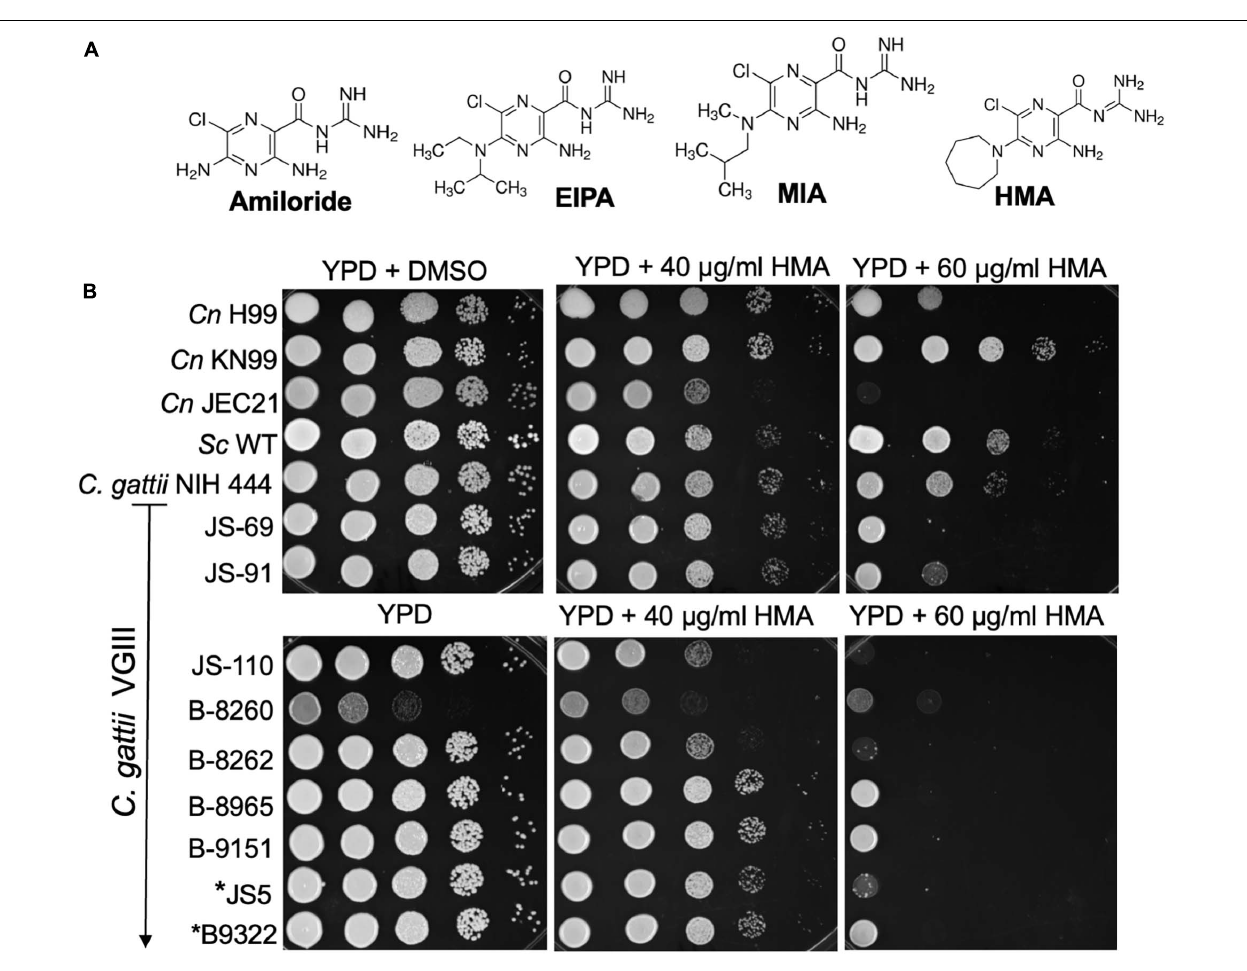
FIGURE 1 | Cryptococcus demonstrates a dose-dependent growth inhibition to HMA. (A) Amiloride and three analogs: EIPA: [5-( N -ethyl- N -isopropyl) amiloride]; MIA: [5-( N -methyl- N -isobutyl)amiloride]; HMA: [5-( N , N -hexamethylene) amiloride]; (B) C. neoformans var. grubii (H99 and KN99), C. neoformans var. neoformans (JEC 21, serotype D), and ten Cryptococcus gattii clinical isolates (ATCC NIH444, JS-69, JS-91, JS-110, B-8260, B-8262, B-8965, B-9151, JS5, and B9322, kindly provided by G. R. Thompson) were examined for their susceptibility to HMA in spot sensitivity assays,. *JS5 and *B9322 were previously identified as flucytosine resistant clinical isolates (Vu et al., 2018). Sc – Saccharomyces cerevisiae , W303a lab strain. Image from three